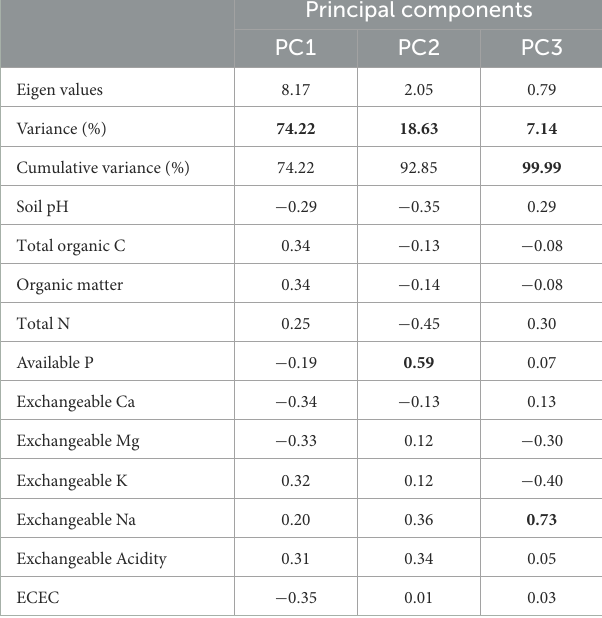
TABLE 7 Principal component analysis for soil properties influenced by the different crop-rotation systems in the top soil (0–20cm).